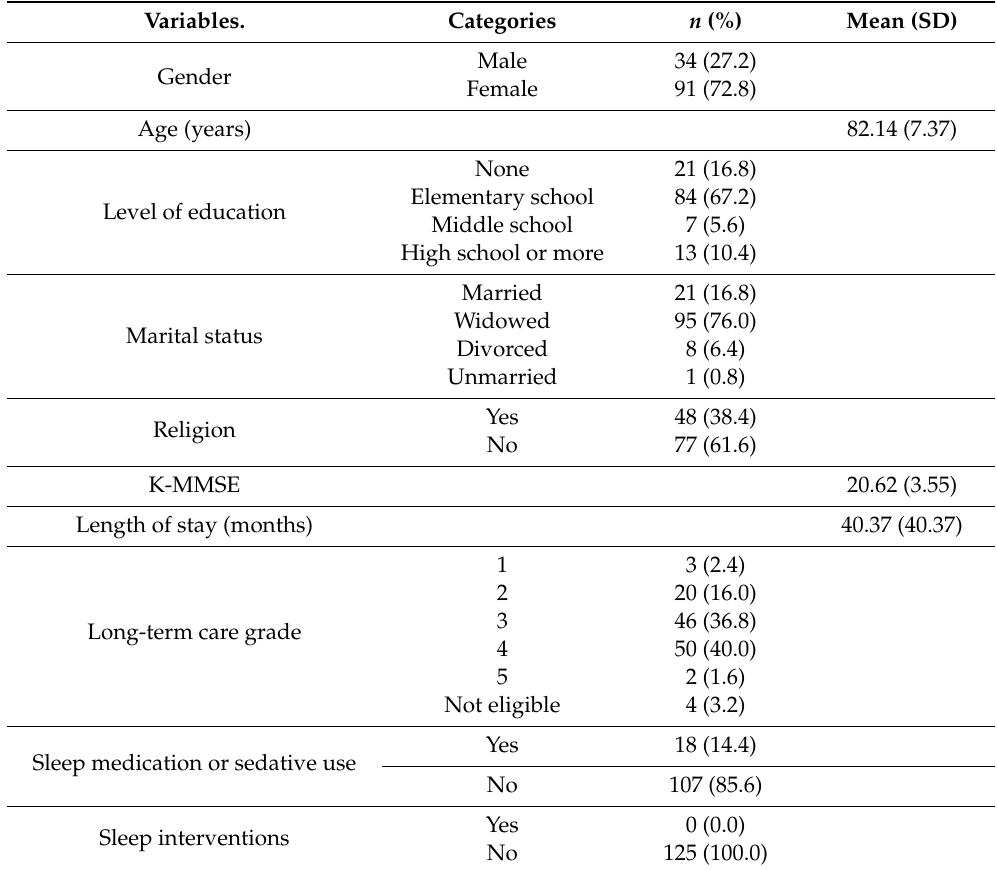
Table 1. General characteristics of the study participants ( n =